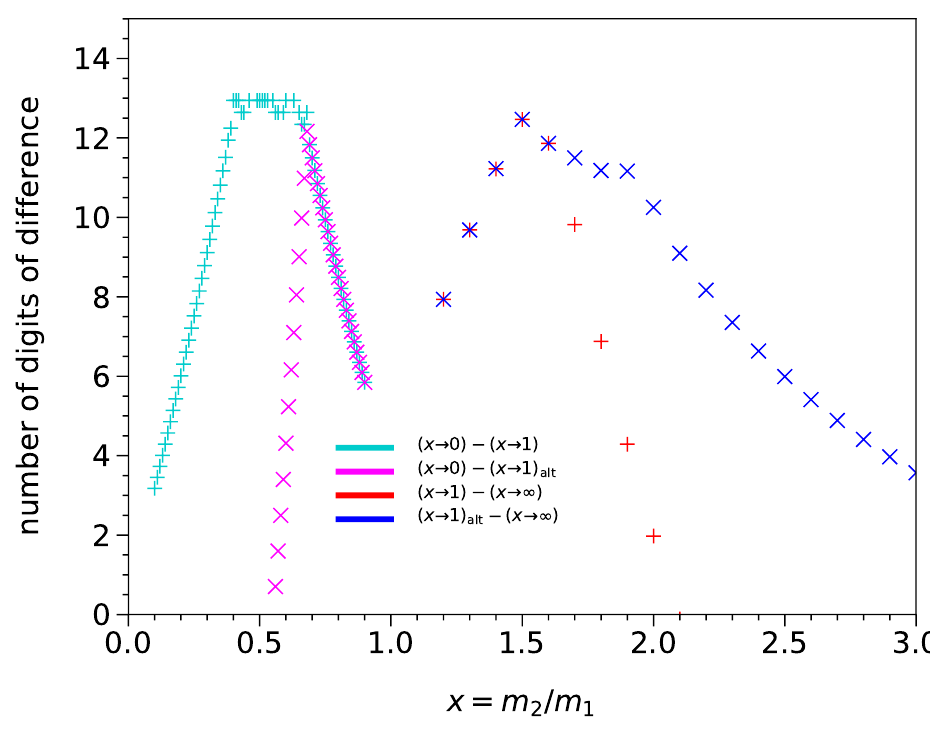
Figure 4: Difference of expansions. The number of digits on the y axis is given by ( difference ) “ − log 10